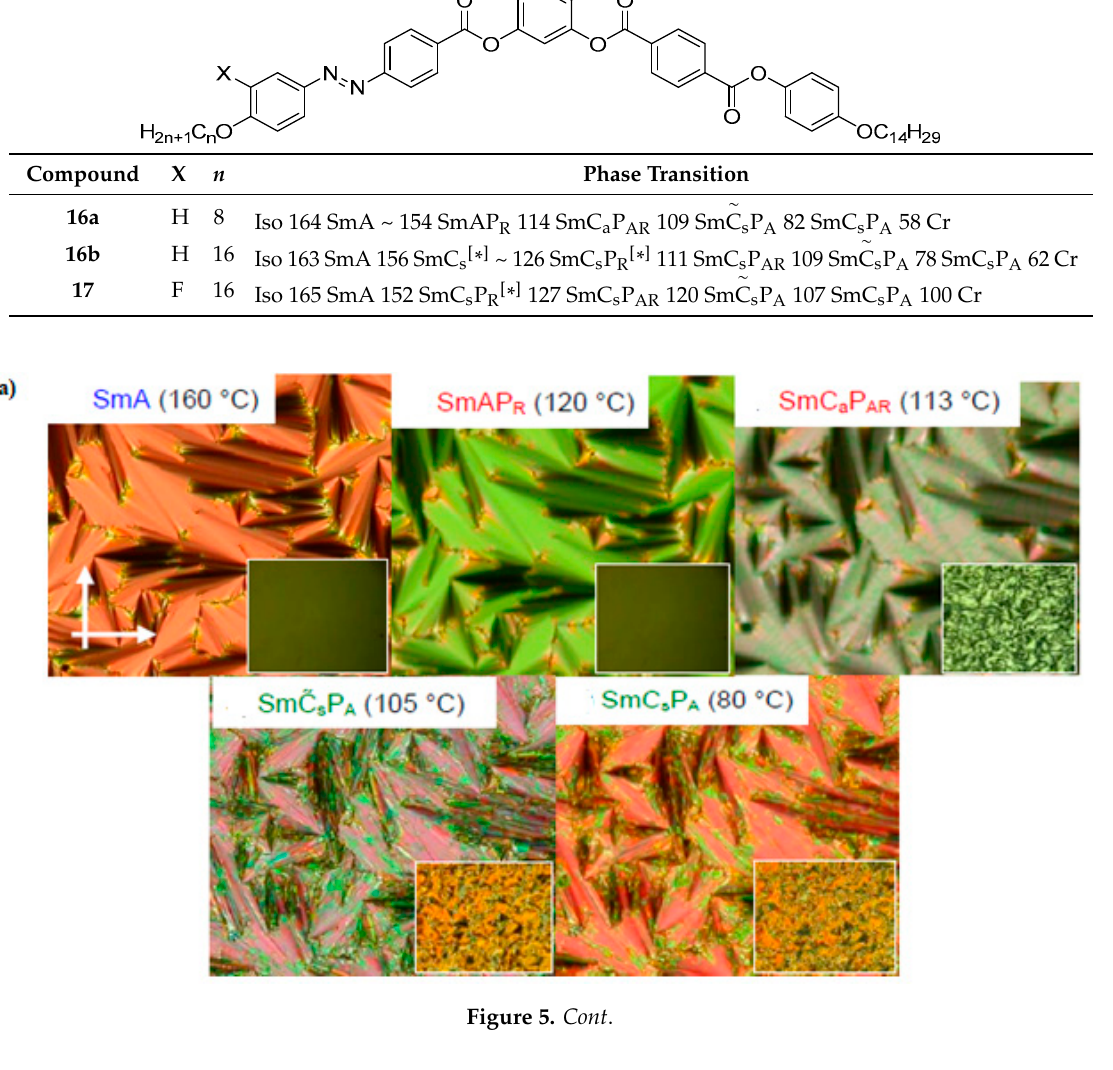
Table 2. Phase transition of homologues of compounds 16 and their derivative 17 .